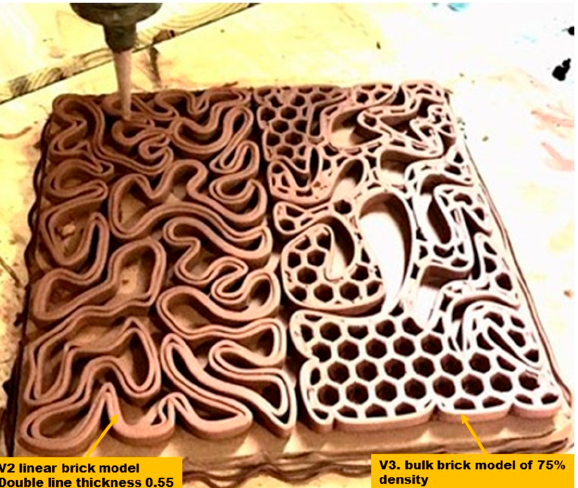
Figure 2. The 3D printing process of the 3D-printed biodigital clay bricks exhibiting the differentiation in printing settings between the linear model (V2) of double line each of 0.55 cm thickness and a bulk model (V3) with honeycomb infill. 3D printing managed by La Maquina by Noumena. (Photo by